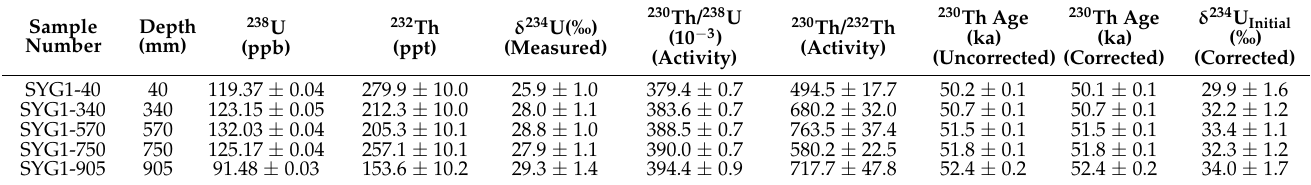
Table 1. 230 Th dating results of stalagmite SYG1 from southern China.